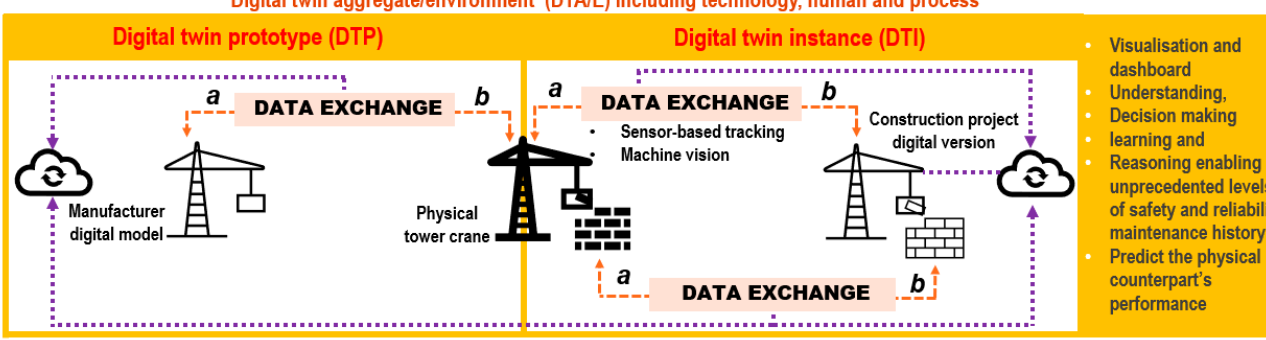
Figure 8. Schematic of the DT, including different dimensions of the DT. A shared DT between stakeholders such as manufacturers and construction contractors is necessary.